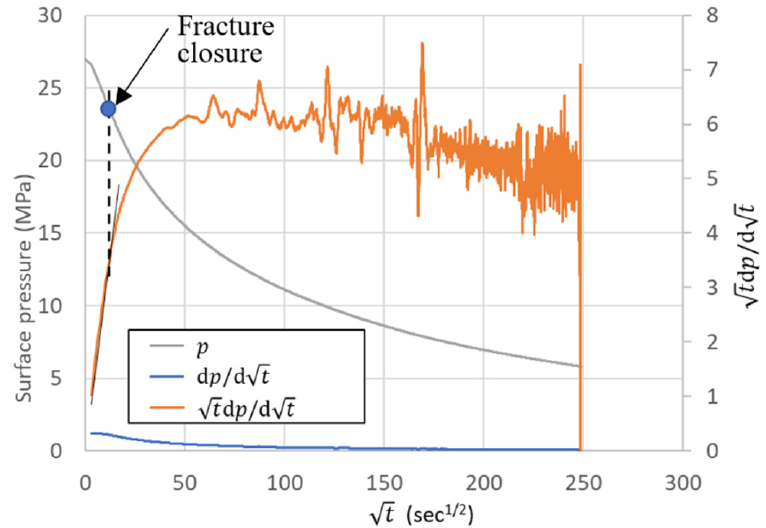
Figure 13. Square root of time plot for Zone 2 Cycle 8. The surface pressure at closure is 23.4 MPa. The calculated bottomhole pressure at closure is 44.9 MPa, and the closure stress gradient is 21.3 MPa/km.